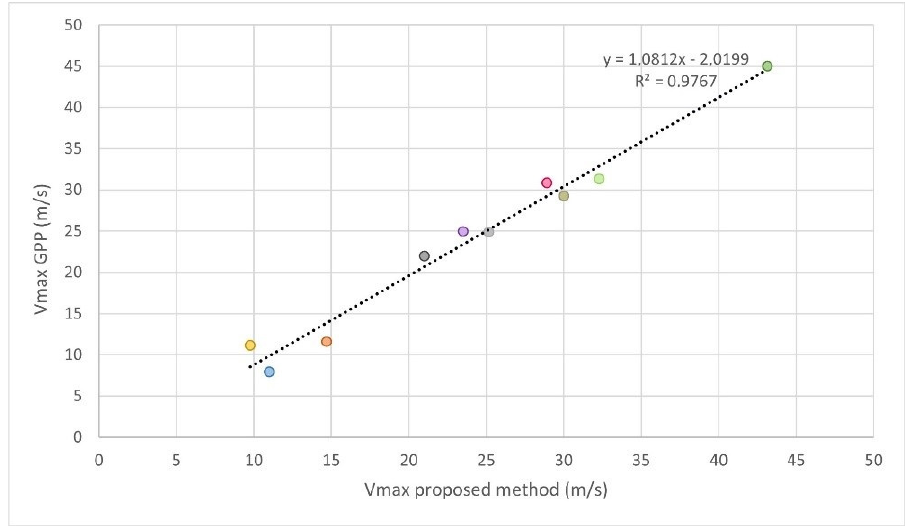
Figure 11. Graph of correlation between the proposed method and GPP model maximum velocity values for ten selected shallow landslides. Each point shown in the graph represents the maximum velocity value of a shallow landslide computed with the two methods.